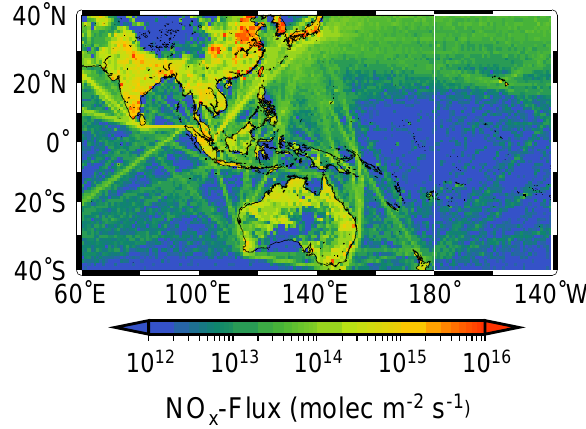
Fig. 1. NO x emissions inventory as used in the model simulation. Estimates are taken from EDGAR3.2FT2000 over land and from Eyring et al. (2005) for ship emissions. The reference sector used in the tropospheric excess method (TEM) from 180 ◦ to 140 ◦ W is marked by the white box.